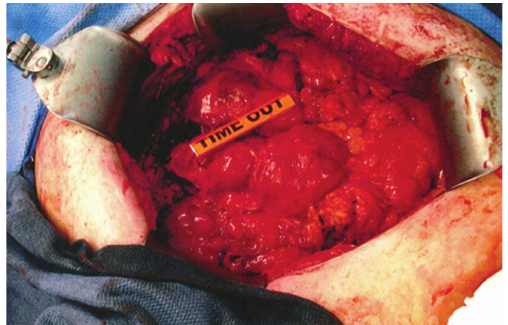
Figure 6: Microscopic examination of the specimen shows predo- minantly mature adipose tissue with scattered islands of trilinear hematopoietic cells including megakaryocytes. No atypia is identi- fied. H&E stain 40 ×